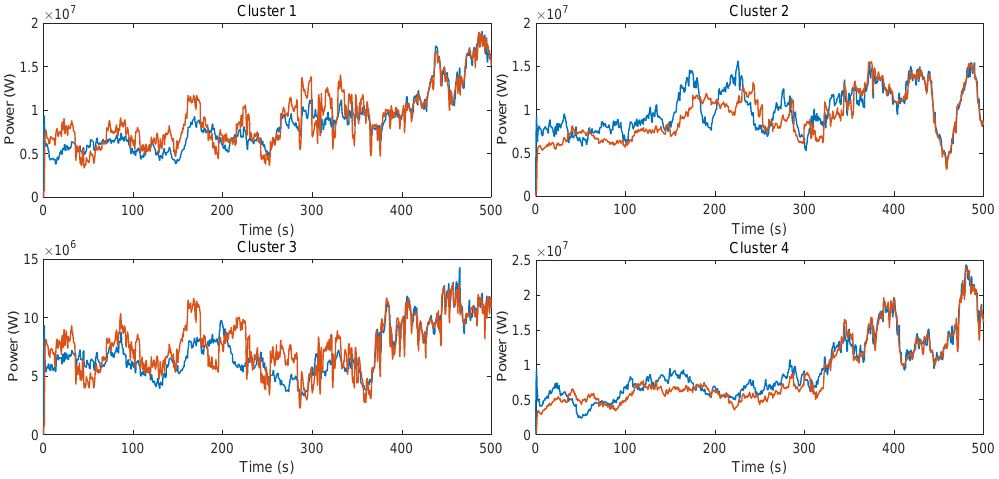
Figure 12. Power output comparison for all four clusters.